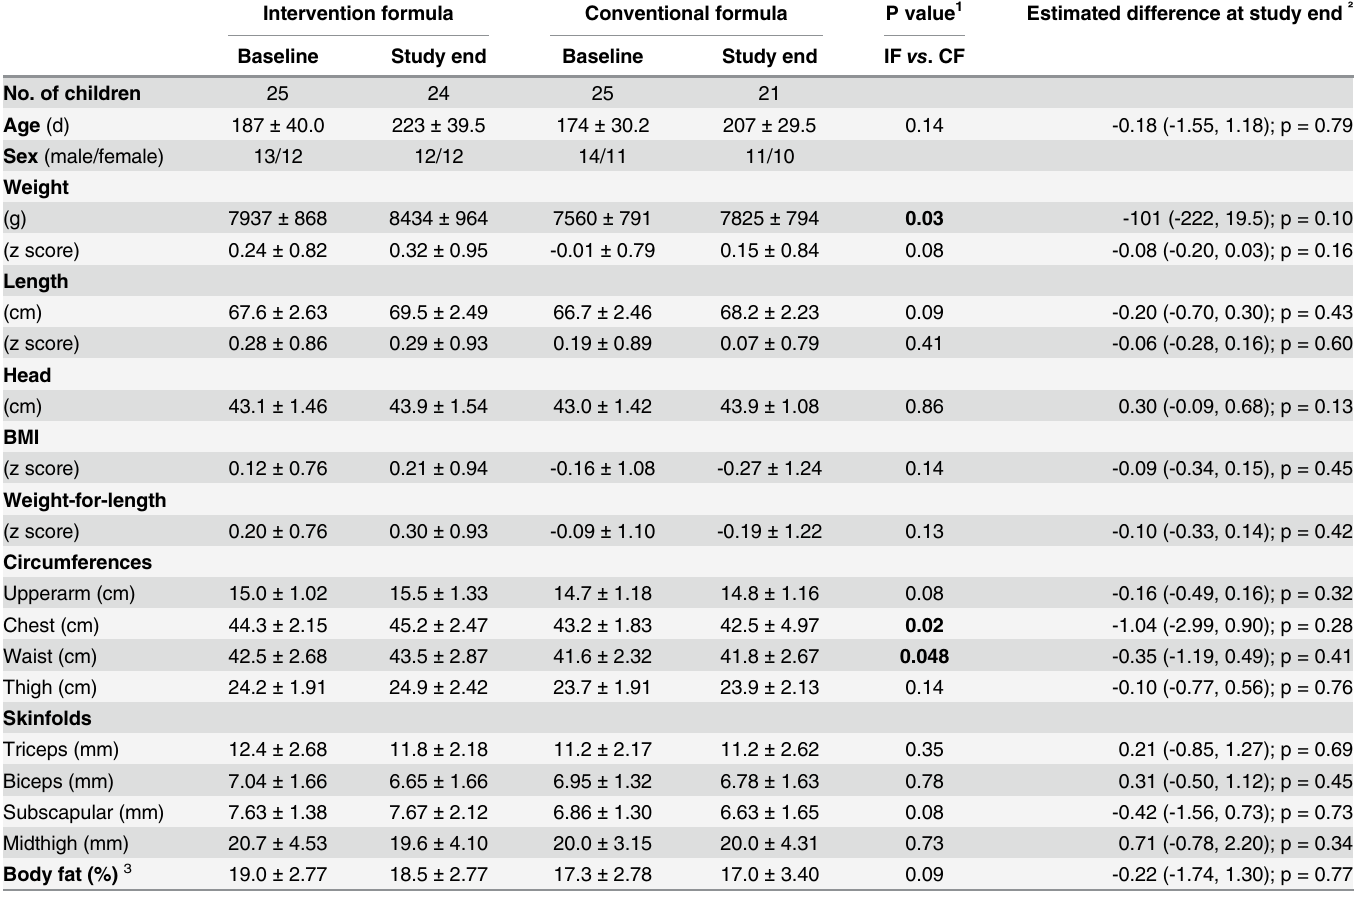
Table 3. Number of children, age at measurement and anthropometric measures with z scores at baseline and study end. Intervention formula Conventional formula P value 1 Estimated difference at study end ² Baseline Study end Baseline Study end IF vs .